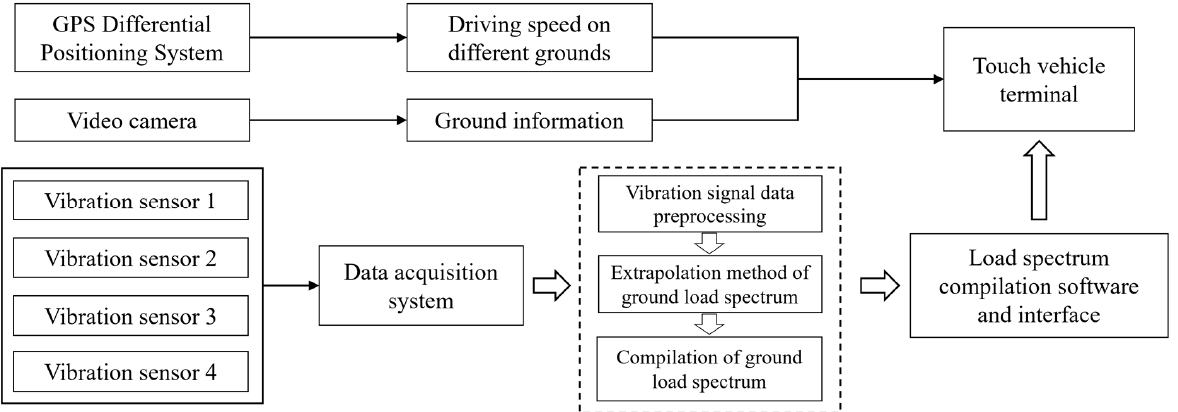
Figure 1. Schematic diagram of the ground load acquisition system.